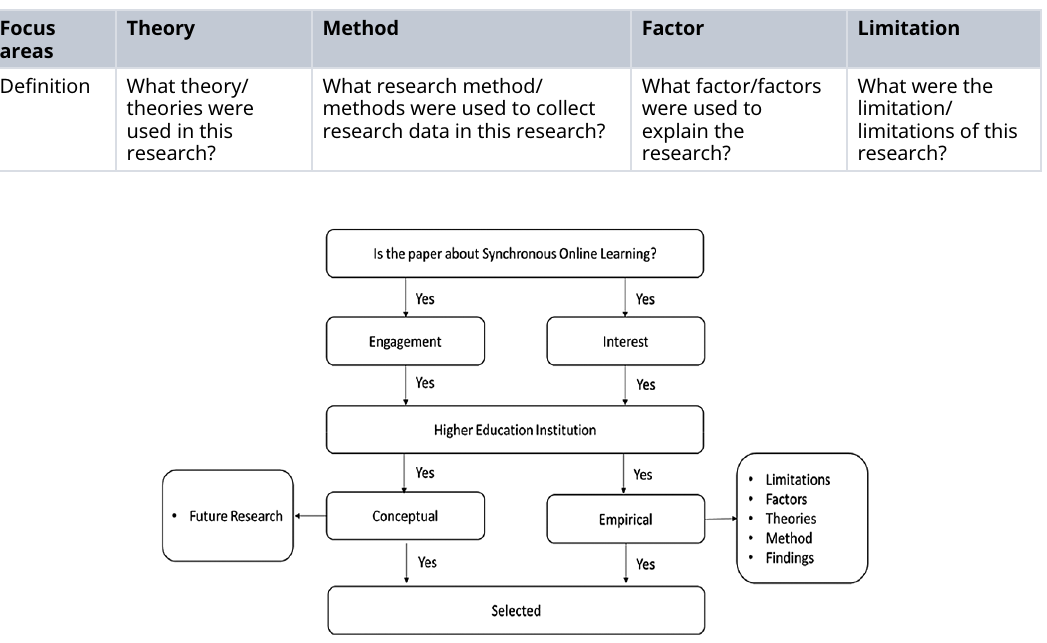
Table 2. Paper search focus